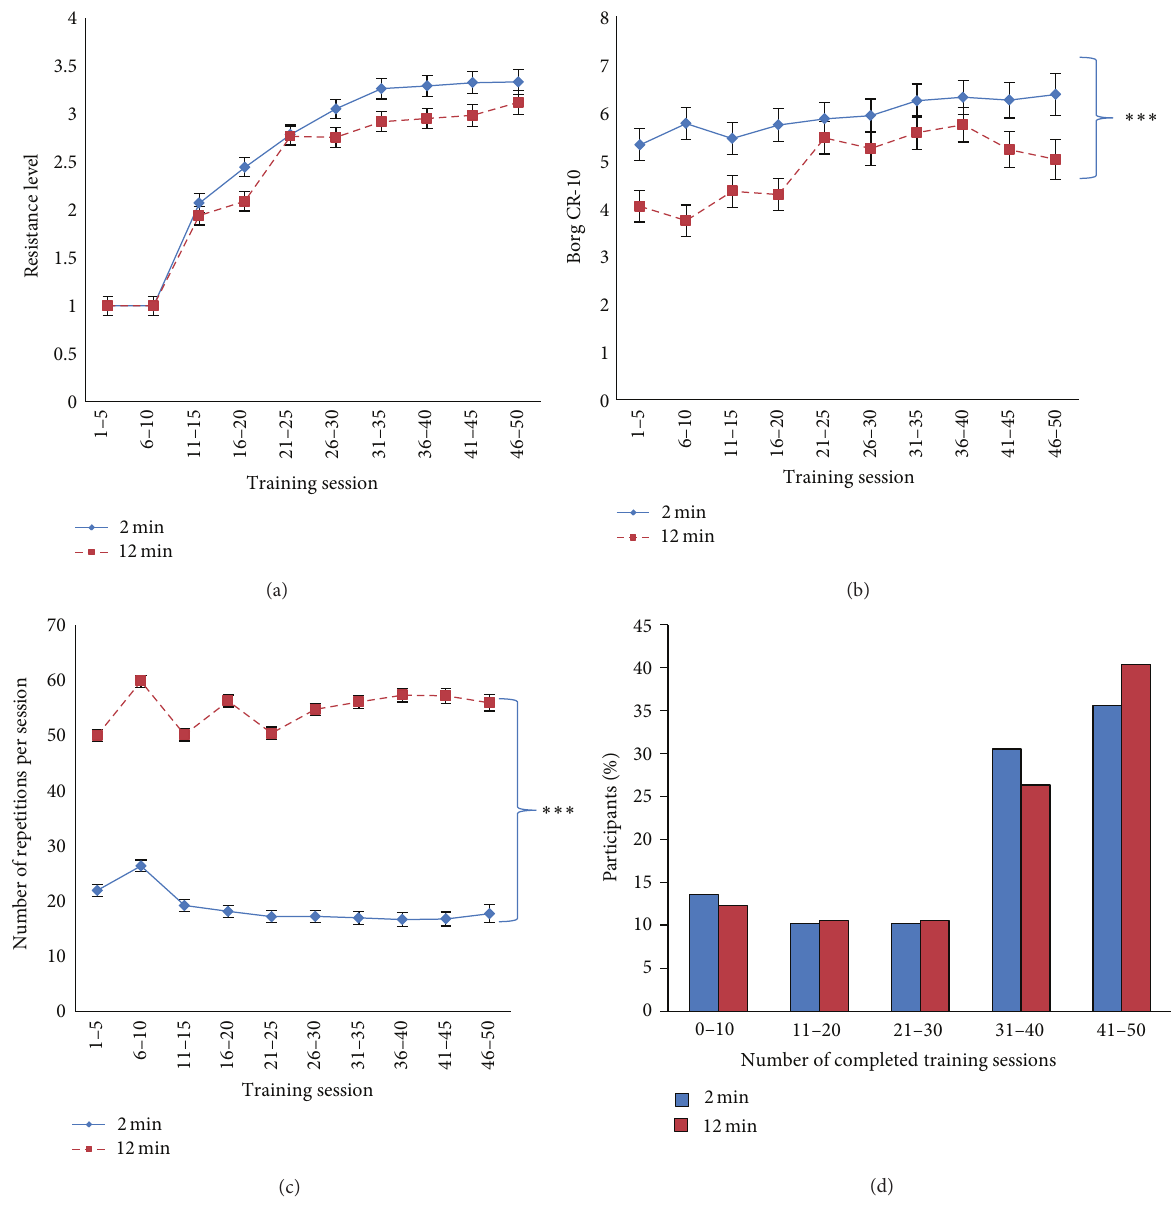
Figure 1: Training diary registrations (fidelity). Progression of resistance (a), physical exertion during training (b), repetitions per training session (c), and percentage of participants completing different number of training sessions (d) in the 2 and 12 min groups. Values are least square means (SE) or percentage of participants. ∗∗∗ Significant group effect (linear mixed model, 𝑃 < 0.001 ).